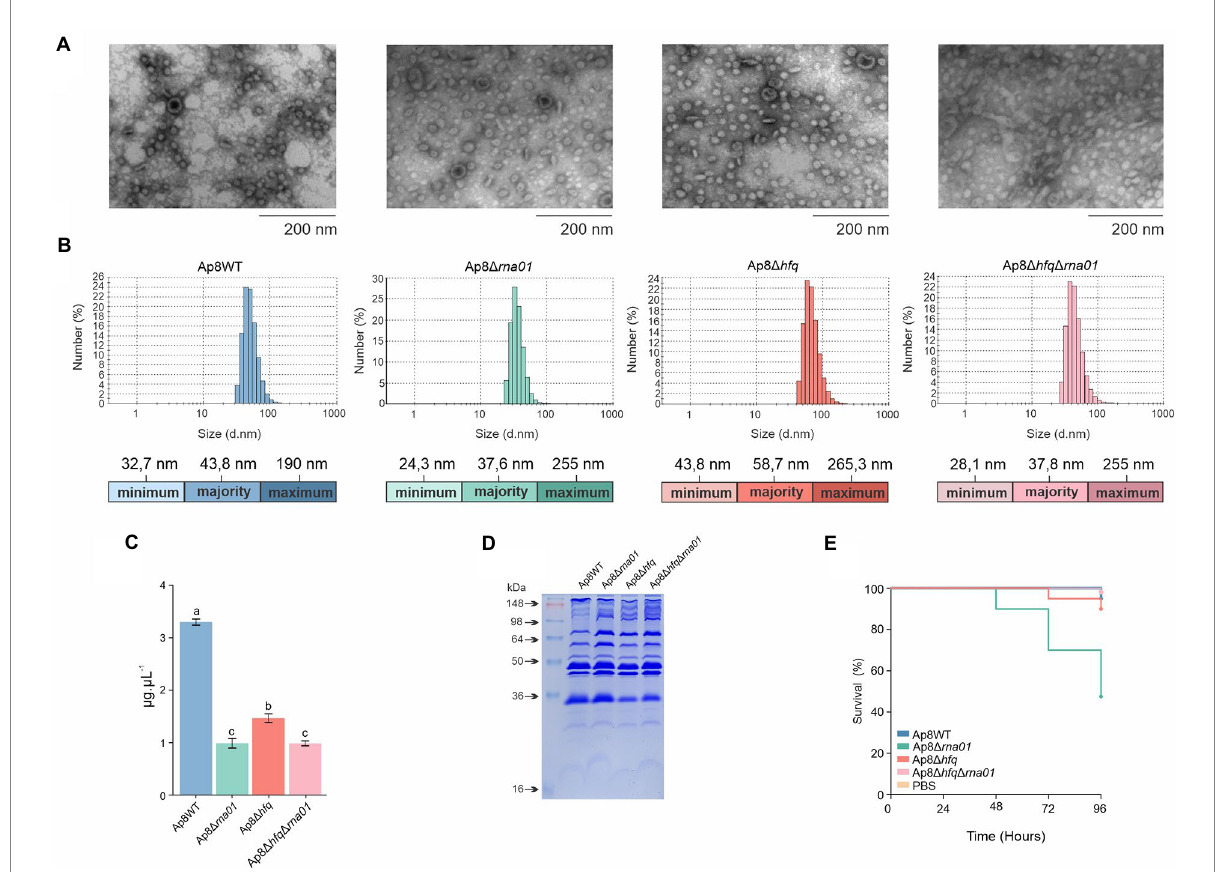
FIGURE 8 Rna01 and extracellular vesicle (EV) production by Actinobacillus pleuropneumoniae . (A) Transmission electron microscopy of EVs produced by A. pleuropneumoniae strains. (B) Size measurement by dynamic scattering light (DLS) of the EVs produced by the strains. Minimum, majority and maximum size of the EVs are shown by colored bars below each graph. (C) Relative abundance of EV production among strains. (D) OMP profile of EVs produced by the strains. (E) Killing assay of G. mellonella after administration of EVs. Means with different letters are significantly different by the Tuckey’s test. The experiment was performed in